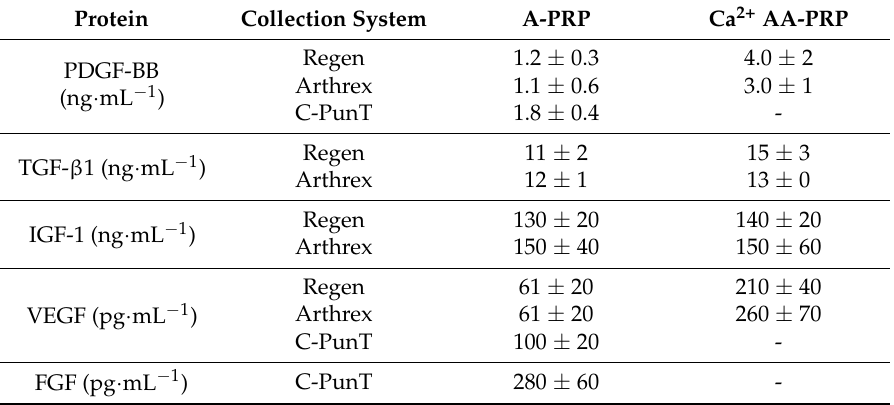
Table 3. Growth factor and cytokine concentrations from A-PRP obtained from Regen, Arthrex, and C-PunT collection systems and for AA-PRP obtained from Regen and Arthrex collection